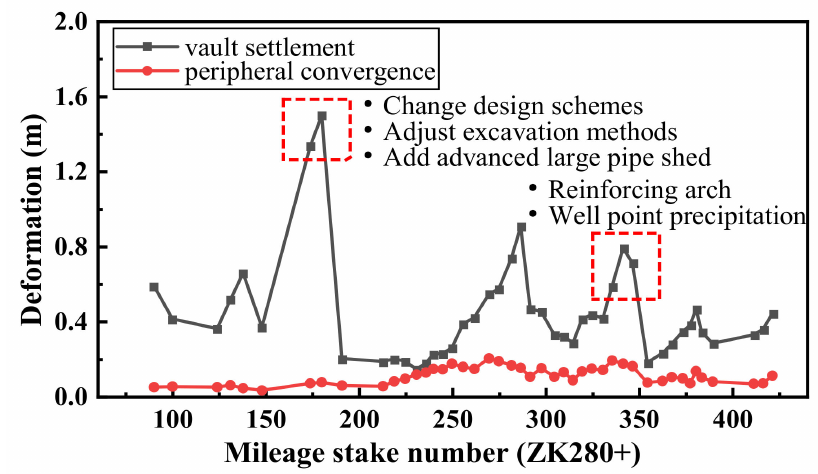
Figure 4. Deformation curves and control measures for the part of the mileage of the left line of the tunnel.